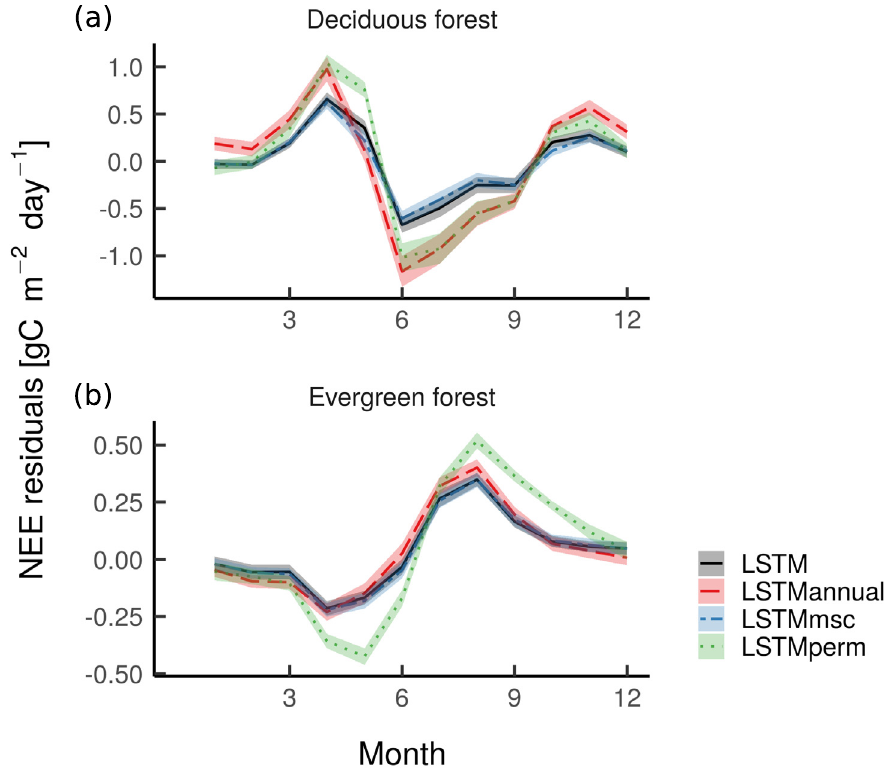
Fig 7. Mean seasonal variation of NEE residuals for LSTM , LSTM perm , LSTM msc , and LSTM annual models for (a) deciduous and (b) evergreen forests. NEE residuals = [NEE observed i , j − mean(NEE observed i )] − [NEE predicted i , j − mean(NEE predicted i )], where i is a unique Fluxnet site and j is a monthly observation. Residual estimates have been calculated based on the mean ensemble ± sd of the 50 model runs. LSTM = LSTM model using the full depth of the Landsat time series and climate data; LSTM = LSTM model but the temporal patterns of both the predictive and perm the target variables were randomly permuted while instantaneous relationships between predictive and target variables were kept; LSTM = LSTM model but the Landsat time series for each band were replaced by their mean seasonal msc cycle, while using the actual values of air temperature (T air ), precipitation (P), global radiation (Rg), and vapor pressure deficit (VPD); LSTM annual = LSTM model but the Landsat time series for each band were replaced by their annual , P, Rg, and VPD, RF = Random Forest model using the actual values of the mean, while using the actual values of T air Landsat time series and climate data. Months for the sites located in the Southern hemisphere have been adjusted to match the seasonal cycle of the sites in the Northern hemisphere.